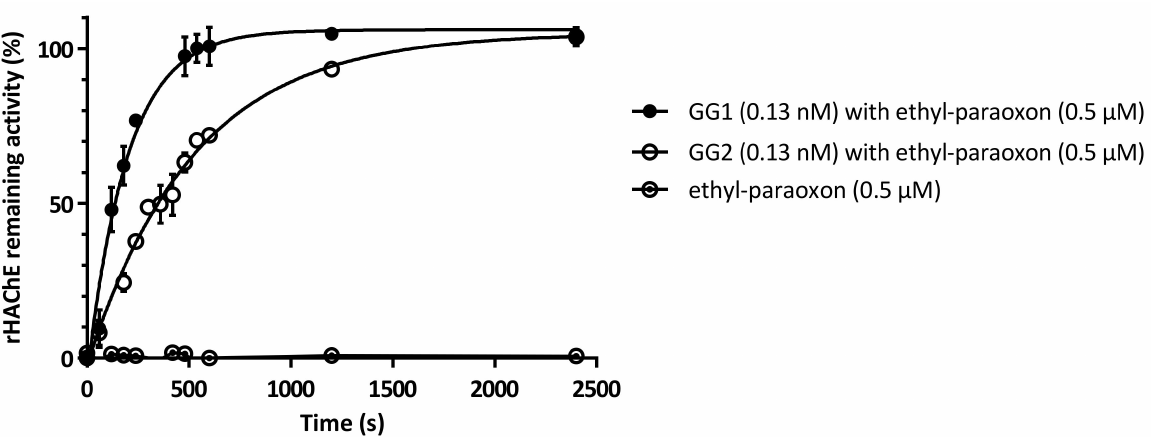
Figure 5. rHAChE inhibition assay [50] with ethyl-paraoxon (0.5 µ M) previously incubated with GG1 or GG2 (0.13 nM) and control without